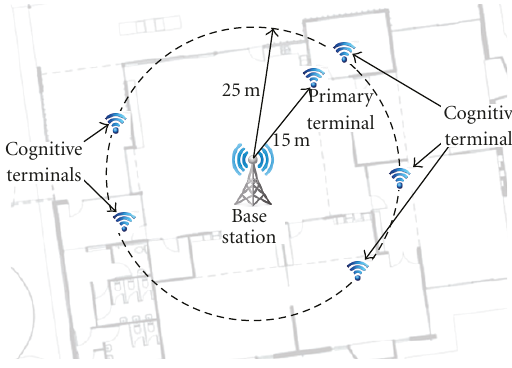
Figure 10: The indoor-to-indoor